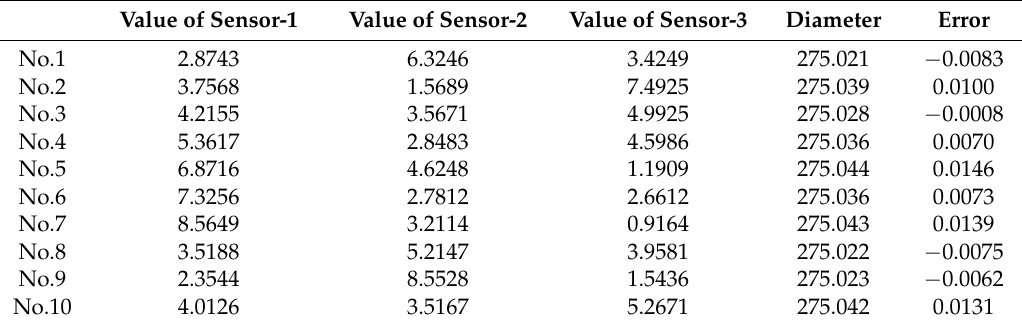
Table 3. Experiment data of inner diameter measurement